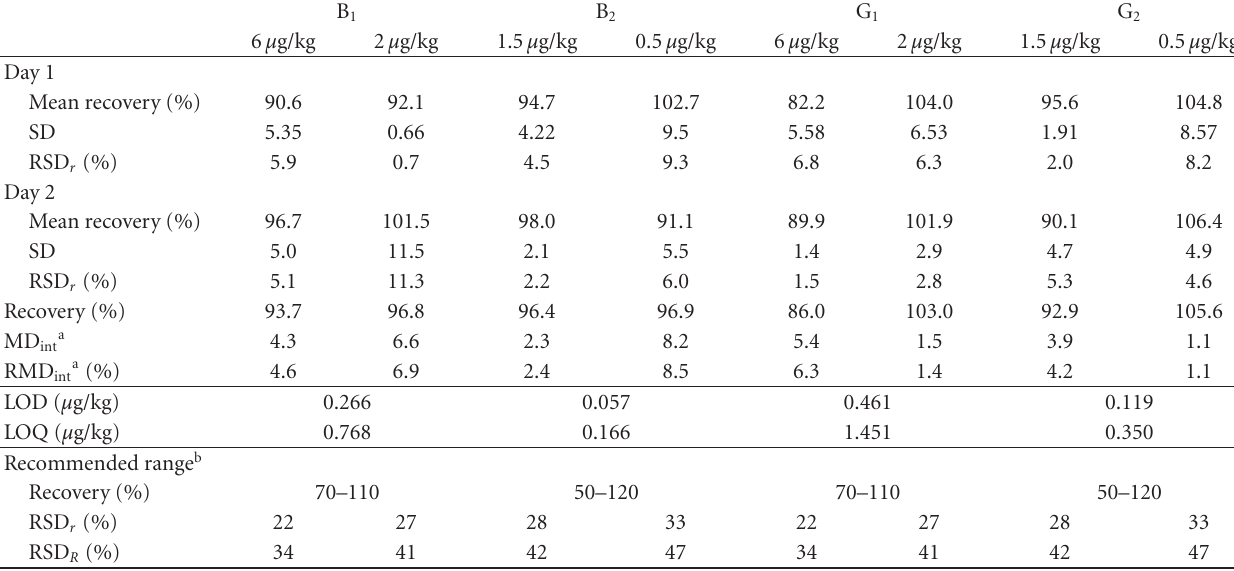
Table 4: Performance and precision of AFs extraction method, for each